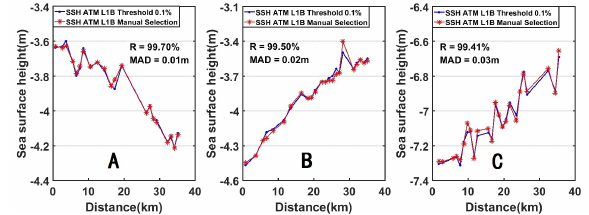
Figure 4. Scatter plots of sea level heights derived from the optimal method over DMS images with leads against the image Figure 2. Sea surfacel heights derived from L1B manual selection and the threshold of 0.1% method over DMS images with leads along the flight direction (C to A), respectively for A, B and C